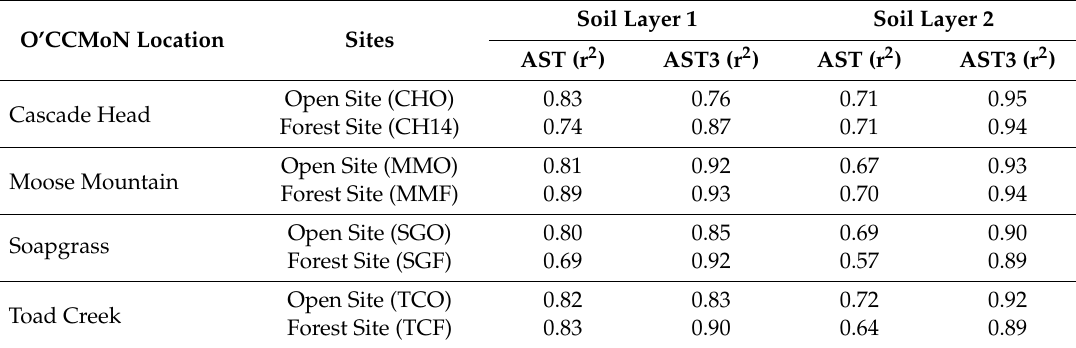
Table 3. VELMA-AST and VELMA-AST3 O’CCMoN